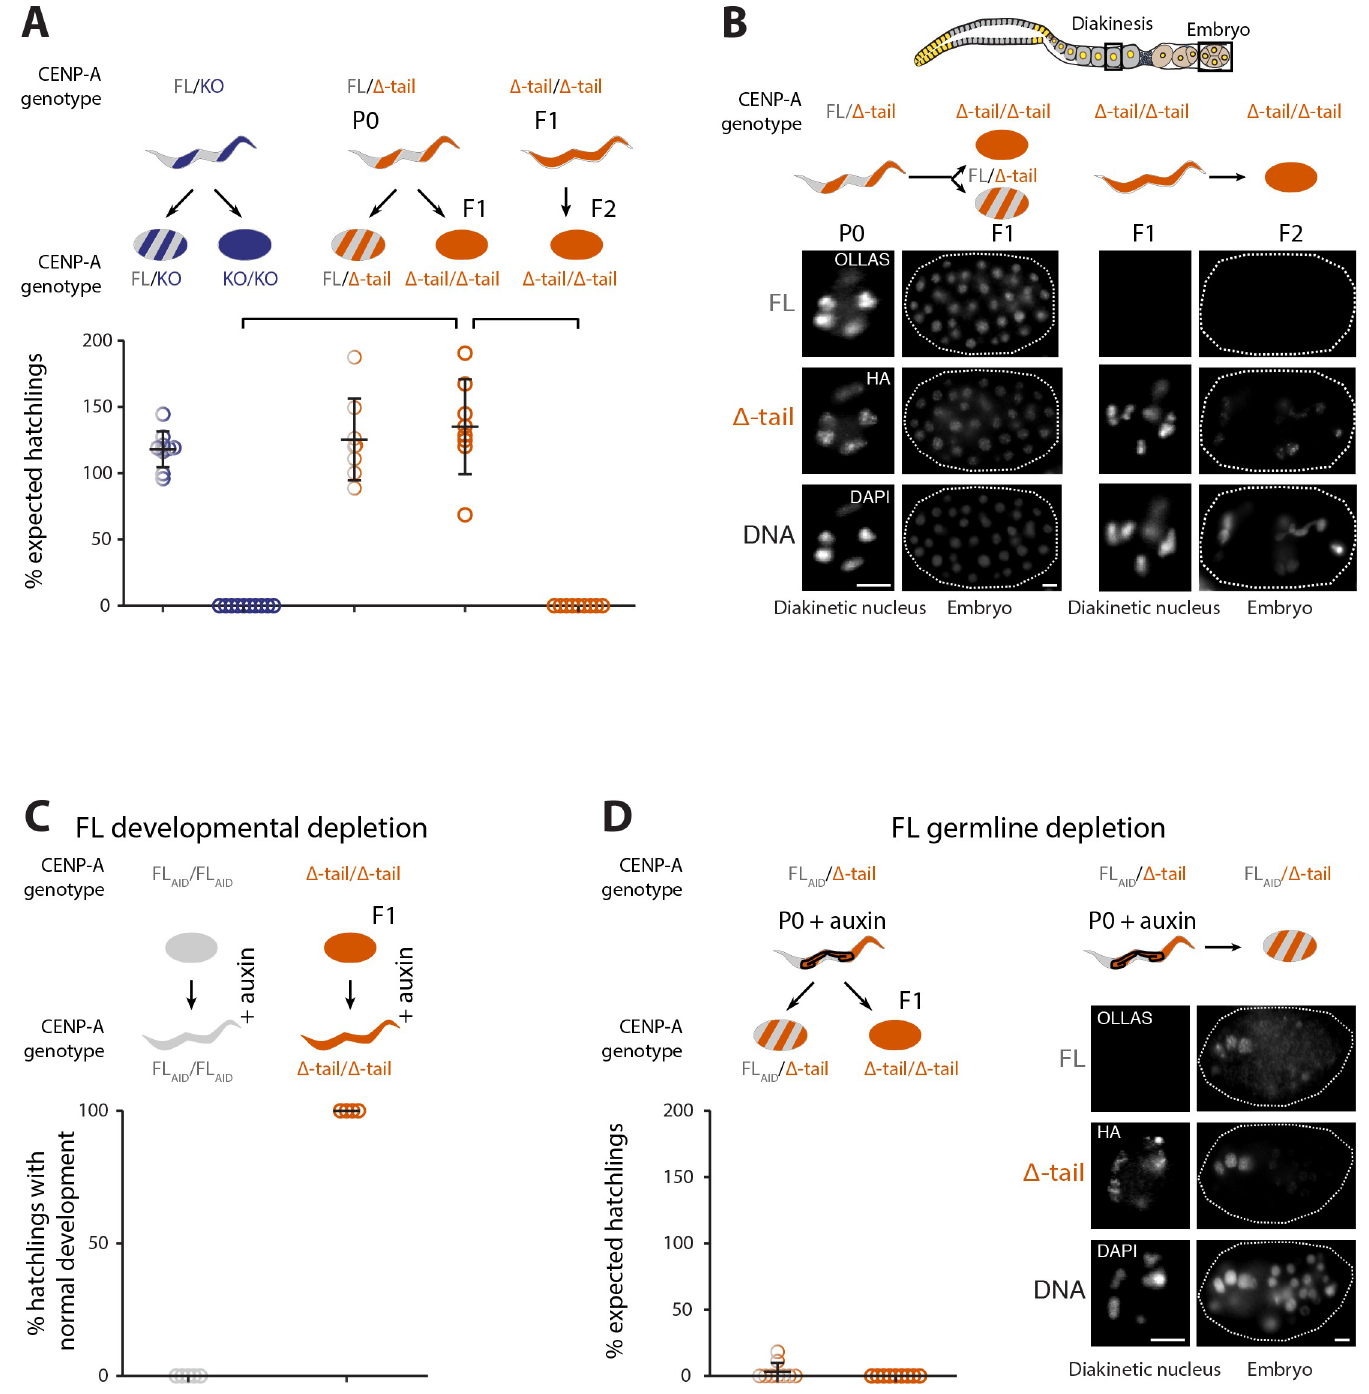
Fig 3. The presence of the CENP-A N-terminal tail is dispensable for mitosis during development but required in the germ line. (A, B) Phenotypic consequences of the CENP-A N-terminal tail deletion in presence or absence of CENP-A FL in the maternal germ line. (A) Quantification of viable offspring of worms carrying CENP-A FL (gray), CENP-A KO mutation (dark blue), or CENP-A tail truncation ( Δ -tail, orange) alleles. A balancer allele (hT2) was used to maintain heterozygous strains. In these balancer strains, 10/16 of the offspring are aneuploid, and CENP-A FL homozygotes (1/16) are embryonic lethal due to the balancer alleles and are therefore not shown. Top, cartoon of maternal heterozygous (striped) or homozygous (full) genotypes as well as genotypes of the offspring. Bottom, quantification of the viable offspring as a percentage of the expected hatchlings in the context of the balancer allele. Error bars show the standard deviation of the mean. Connecting lines highlight the most relevant comparisons between the different genotypes. N = 8 to 10 independent broods. (B) Cartoon of an adult germ line, with imaged regions highlighted with black boxes. IF images of both the CENP-A FL and CENP-A Δ -tail proteins in the maternal germ line (diakinesis) and embryos. Left, maternal CENP-A FL/ Δ -tail